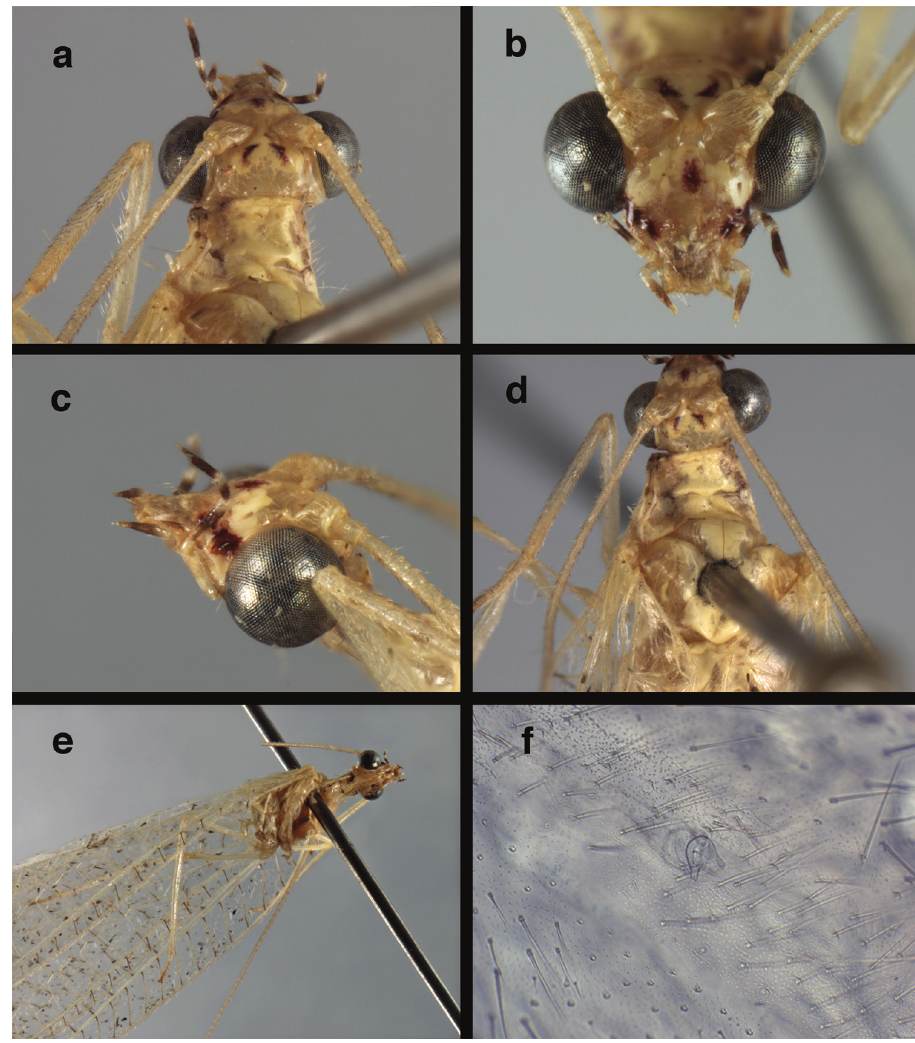
Figure 88. Ungla stangei Tauber, sp. n. External features, ( a ) head, dorsal ( b ) head, frontal ( c ) head, lateral ( d ) head, thorax, dorsal ( e ) head, thorax, ventral ( f ) male abdominal spiracle (all: Bolivia, La Paz, male; a–e holotype, CAS; f paratype,